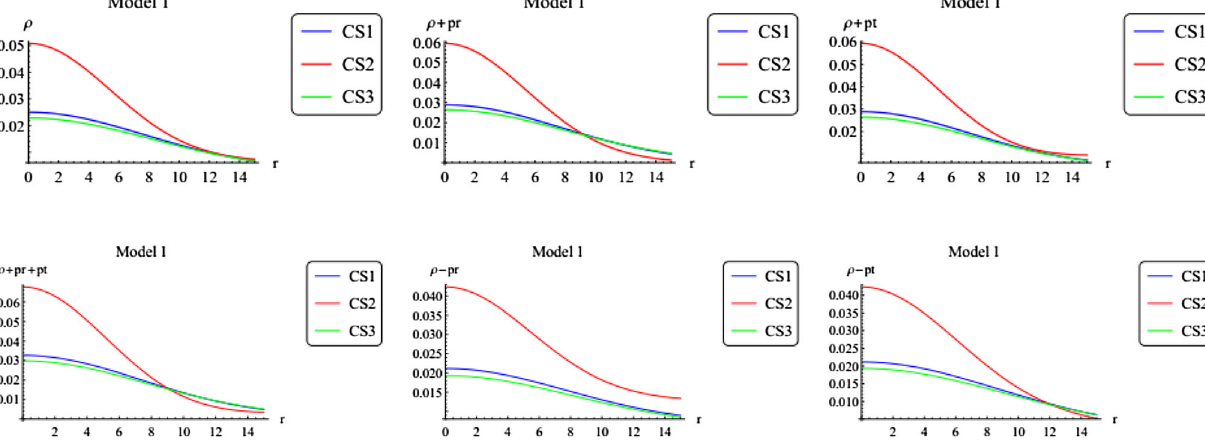
Fig. 7 Different energy conditions for Model